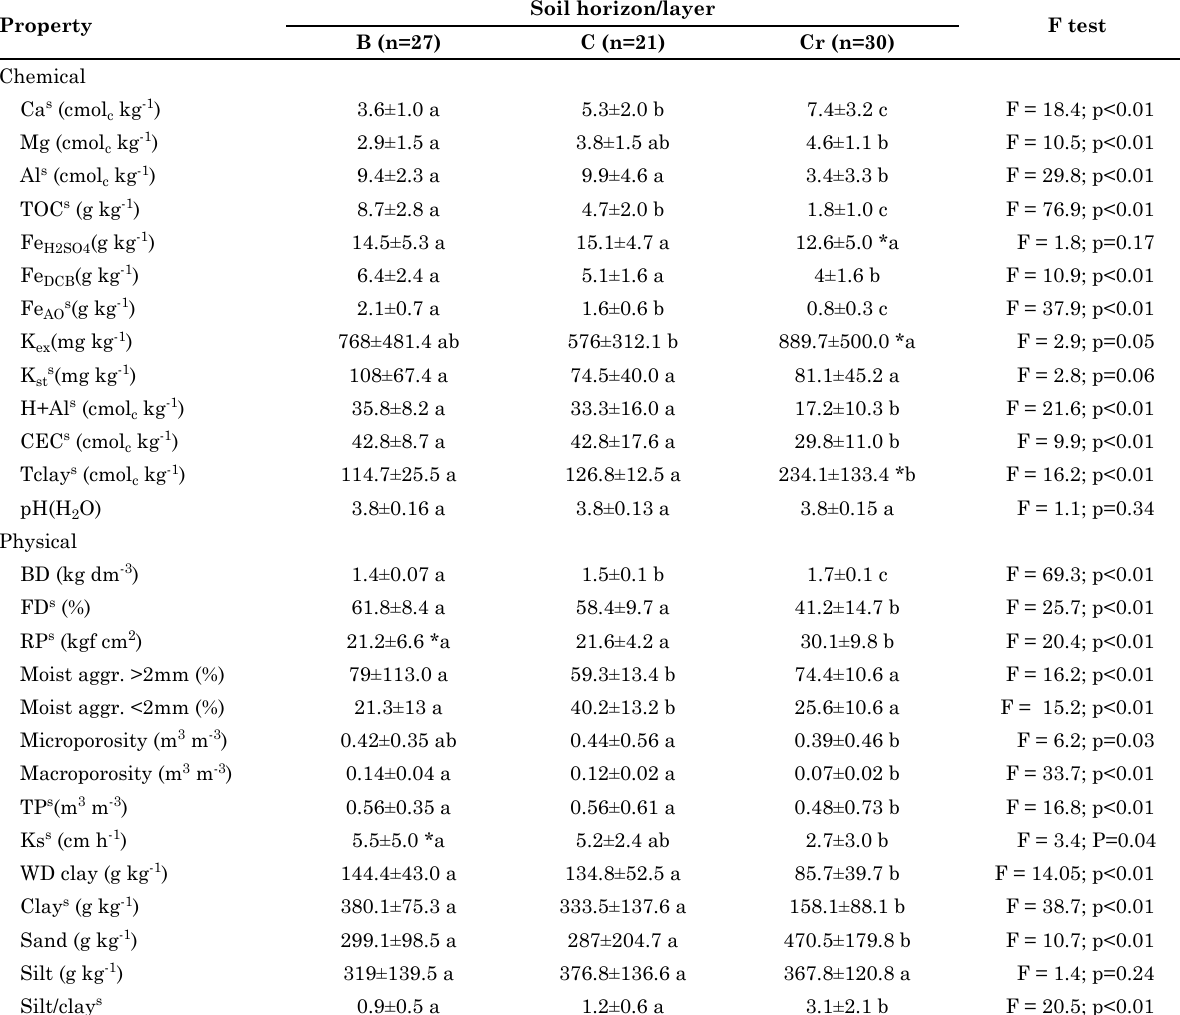
Table 3. Average, standard deviation, and ANOVA test of the soil chemical and physical properties